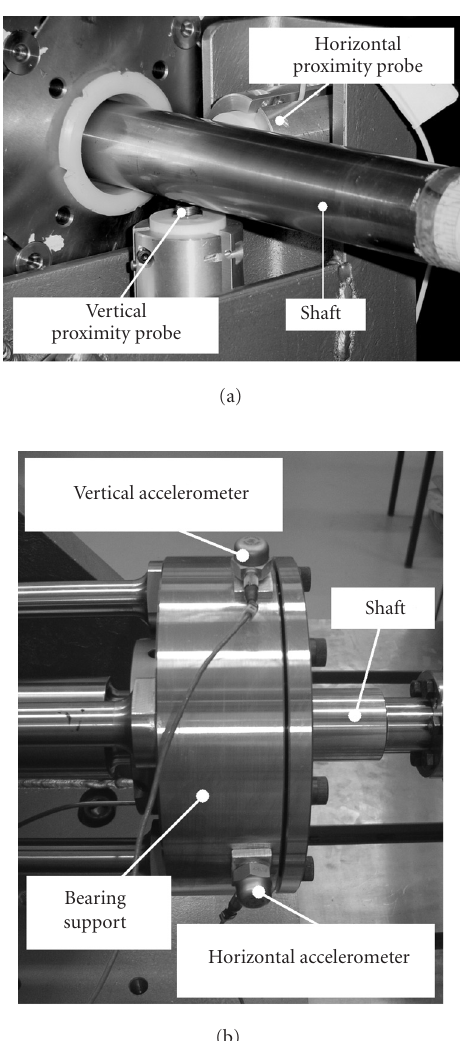
Figure 2: Detail of two planes of measures: (a) proximity probes and (b)